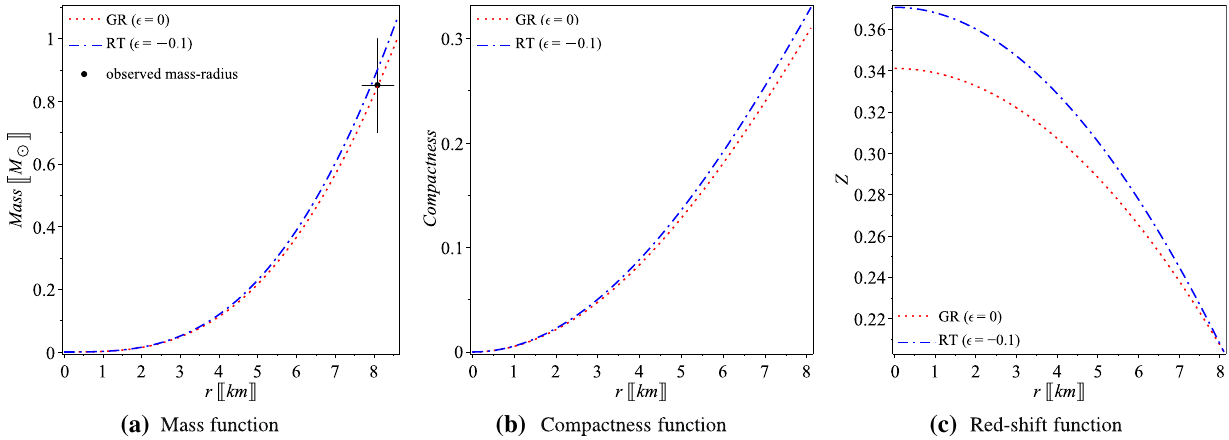
Fig. 5 a , c The behaviours of the EoS parameters, defined as w r ( r ) = p r /ρ and w t ( r ) = p t /ρ , at different radial distances within the pulsar Her X-1 as predicted by RT and GR. We note that no EoS are imposed